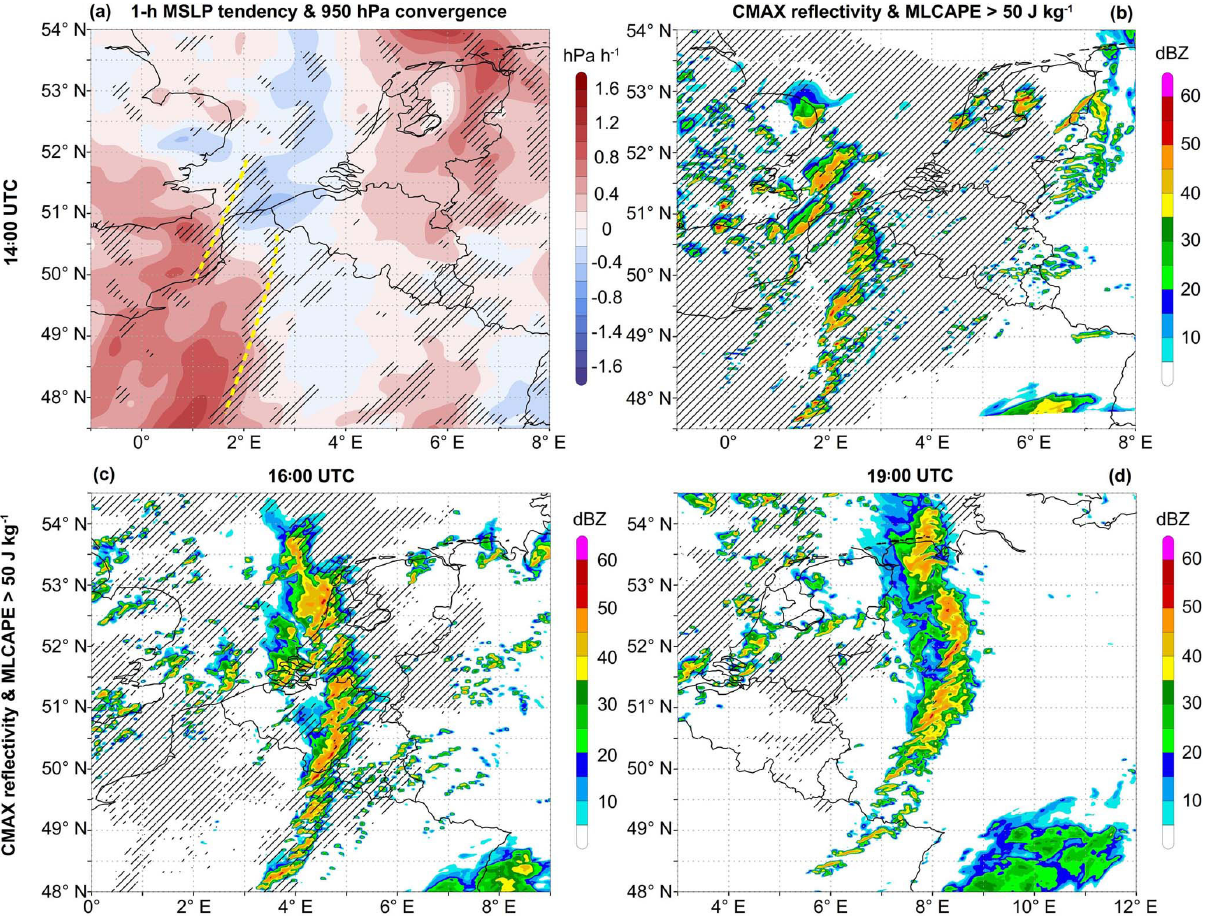
Figure 10. Results from CCLM-ERA5 at (a, b) 14:00UTC, (c) 16:00UTC and (d) 19:00UTC. (a) 1-hourly mean sea level pressure (MSLP) tendency (hPah − 1 ; shaded) and 950hPa convergence smaller than − 5 × 10 − 5 s − 1 (hatched areas) from the 7km simulation. (b, d) Column maximum reflectivity (dBZ; shaded) and 50hPa mixed-layer CAPE above 50Jkg − 1 (hatched areas) from the 1.1km simulation. The dashed yellow lines in (a) denote the convection-initiating convergence